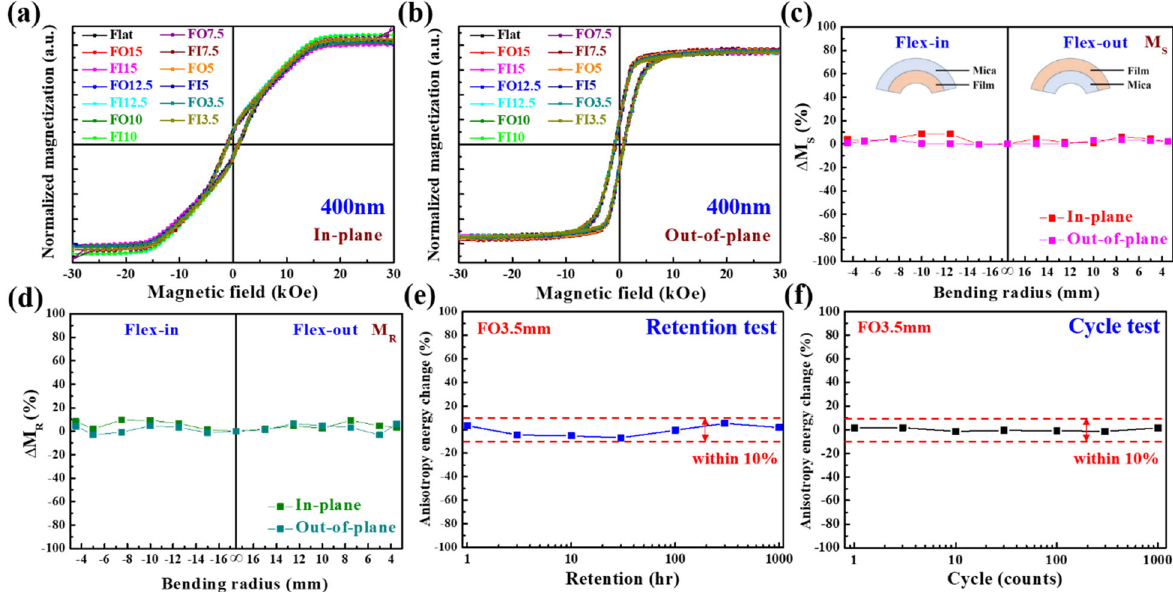
Fig. 4 Bending tests. Hysteresis loops under different bending radii with a IP magnetization and b OOP magnetization. Changes in c saturation magnetization and d remanence under different bending radii. The insets in c show two different modes: fl ex-in (FI) (left), fl ex-out (FO) (right). e Time and f bending cycle dependence of the anisotropy energy change for an FO bending radius of 3.5